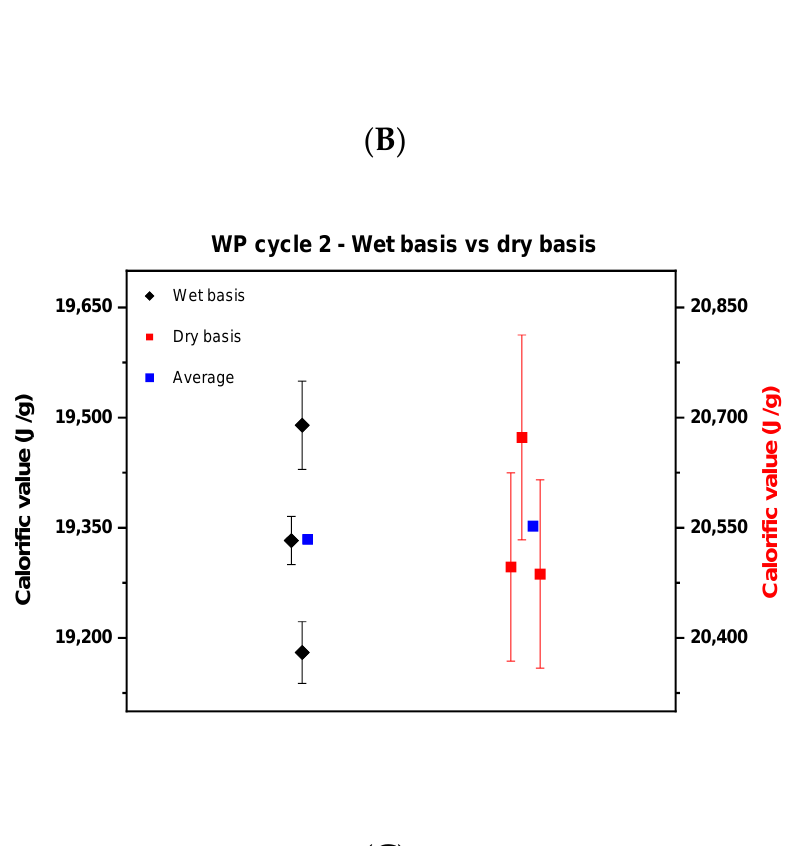
Figure 4. Comparison between the calorific value on a wet basis and dry basis in cycle 2. ( A ) describes wood chips—industrial quality, ( B ), wood chips—high quality, and ( C ) the wood pellets. Figure 5 reveals that there is a large difference in the moisture value of cycle 1 be- tween the institutes, especially between BRML and TUBITAK with around 6% difference. In cycle 2 the values were relatively consistent yet not exact with a difference between the values of around 0.6%. This was due to the fact that the samples used in cycle 2 stem